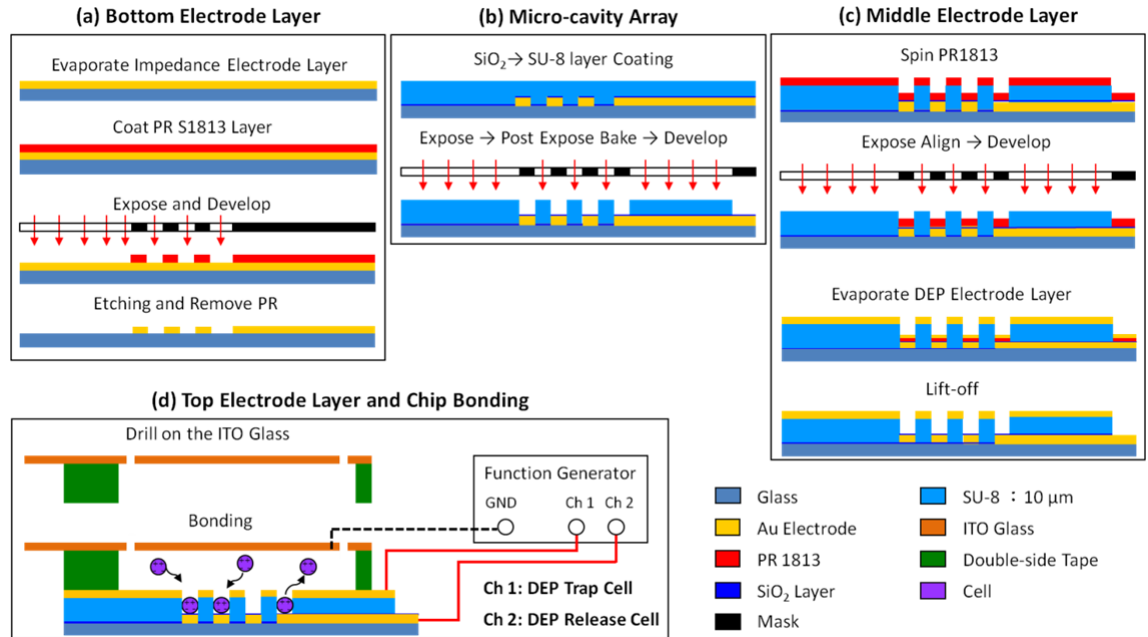
Figure 6. The microfabrication processes of DEP chip.